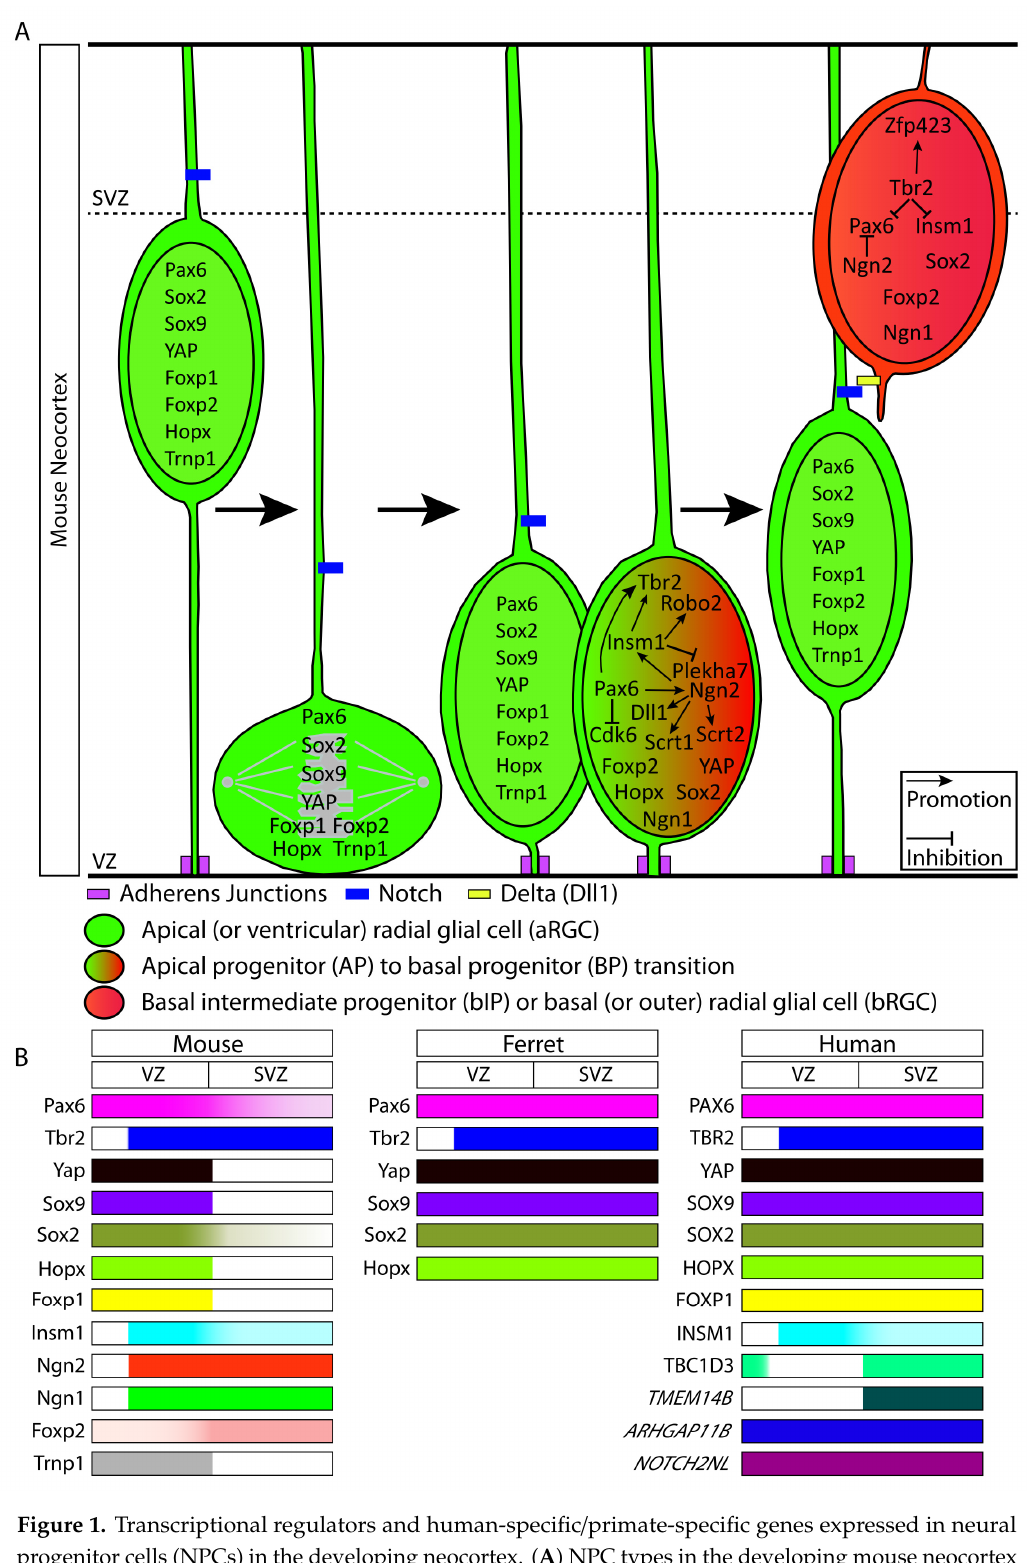
Figure 1. Transcriptional regulators and human-specific / primate-specific genes expressed in neural progenitor cells (NPCs) in the developing neocortex. ( A ) NPC types in the developing mouse neocortex showing the transcriptional regulators expressed in each NPC type. For the NPC types and arrows, see keys. ( B ) Expression pattern of the transcriptional regulators and human-specific / primate-specific genes in the two principal germinal zones, i.e., VZ and SVZ, across mouse, ferret and human. Color intensity in each bar represents the relative expression of the respective protein or mRNA (italics) in the VZ and the